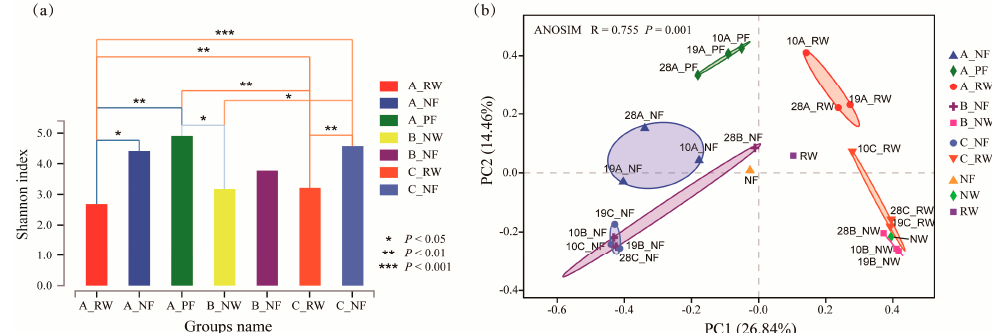
Figure 2. Alpha and beta diversity of the microbial communities from different groups. ( a ) Shannon index of alpha diversity and differences among groups (*: p < 0.05, **: p <0.01 and ***: p < 0.001); ( b )